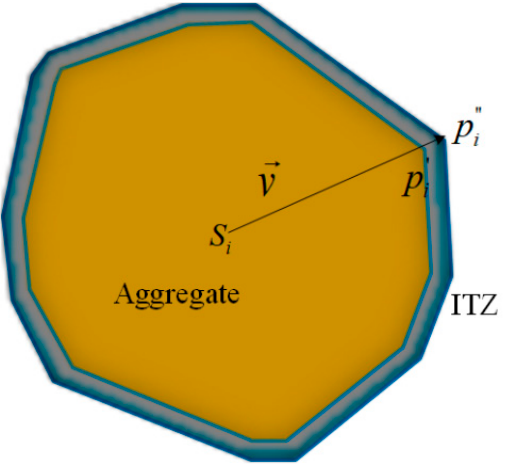
Figure 4. Schematic diagram of generating an interfacial transition zone (ITZ).